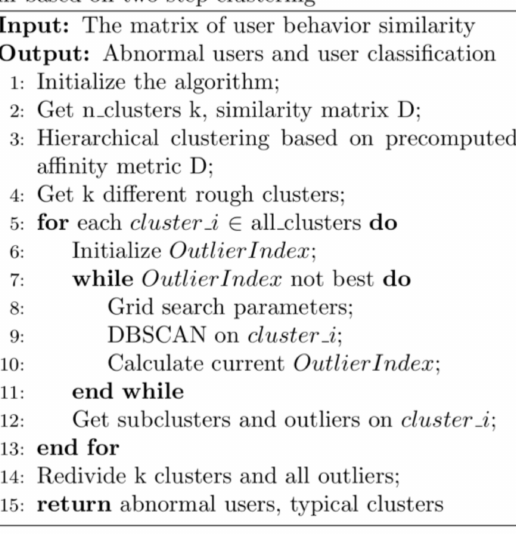
Figure 6. Algorithm